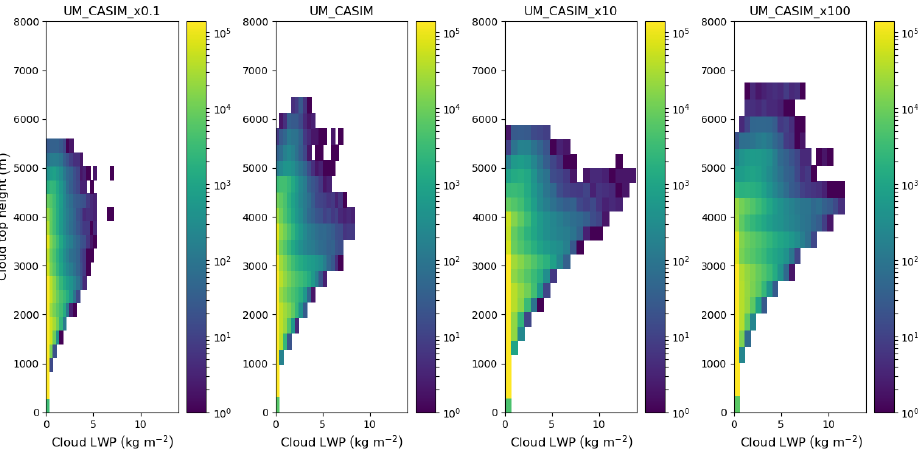
Figure 10. Joint histograms of liquid water path and cloud top height for each simulation, with aerosol increasing from left to right along the figure.